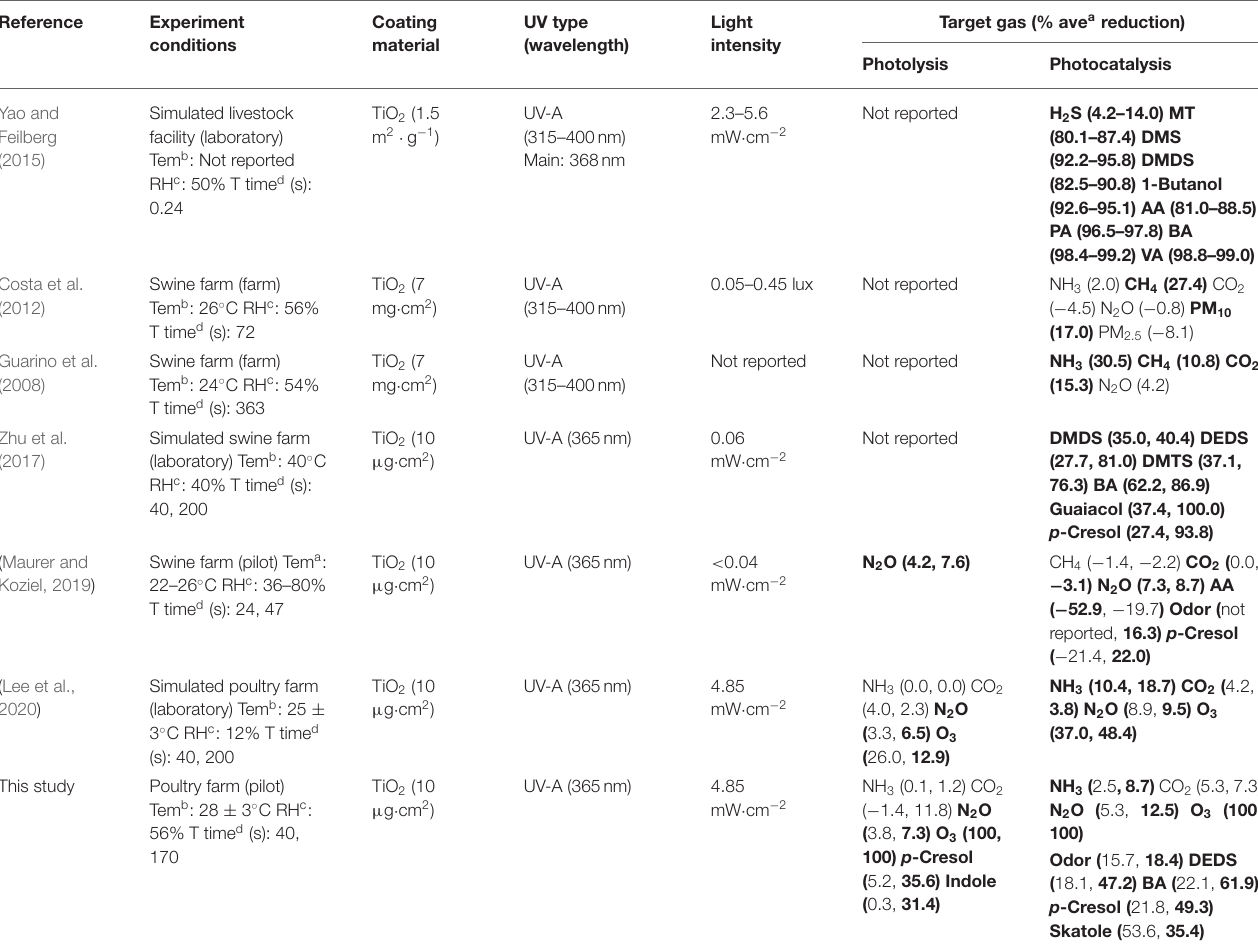
TABLE 12 | Summary of % reduction for selected target gas with TiO 2 and UV-A light in the livestock farm condition.